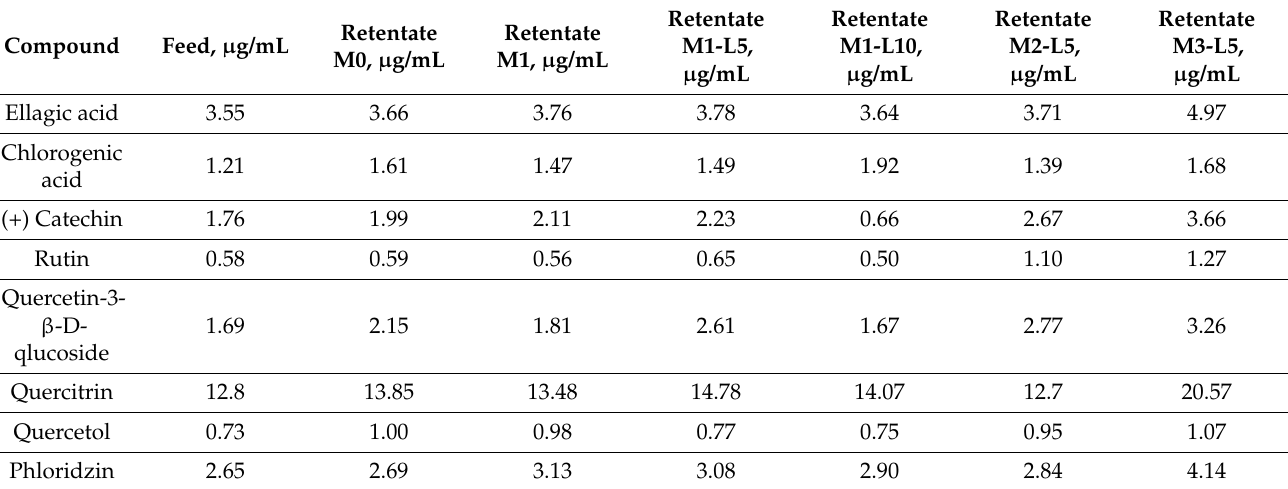
Table 3. HPLC-MS analysis for apple pomace retentate